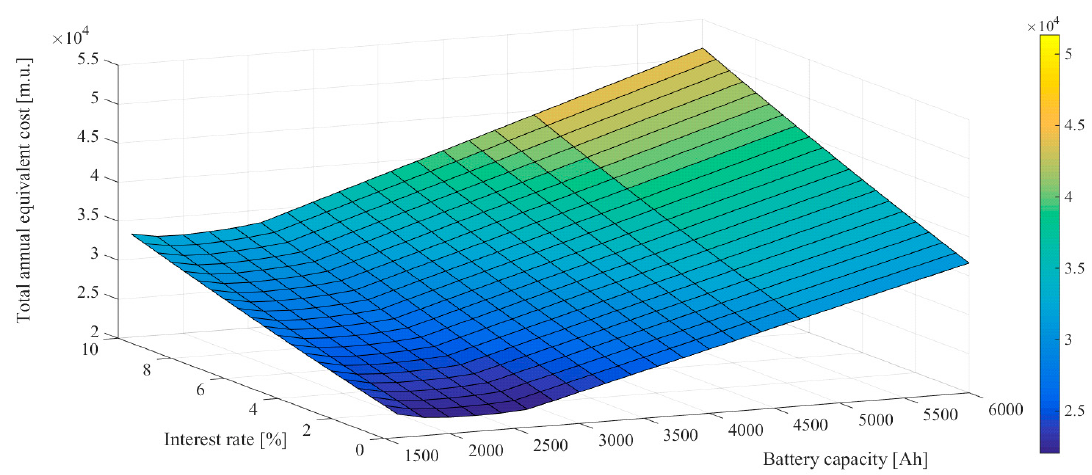
Figure 16. Equivalent annual total cost with respect to the interest rate without inflation and to the